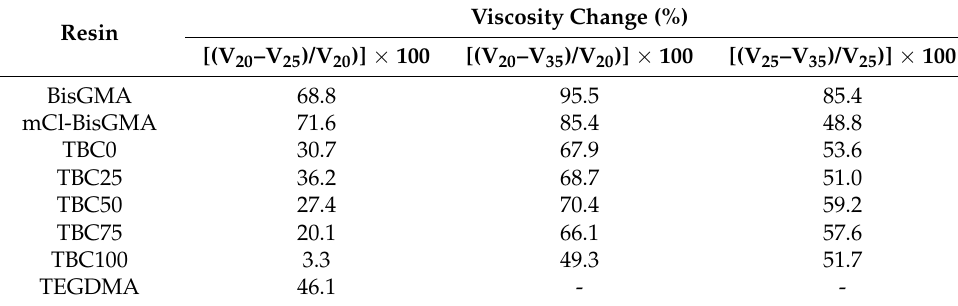
Table 3. Percentage of viscosity change with